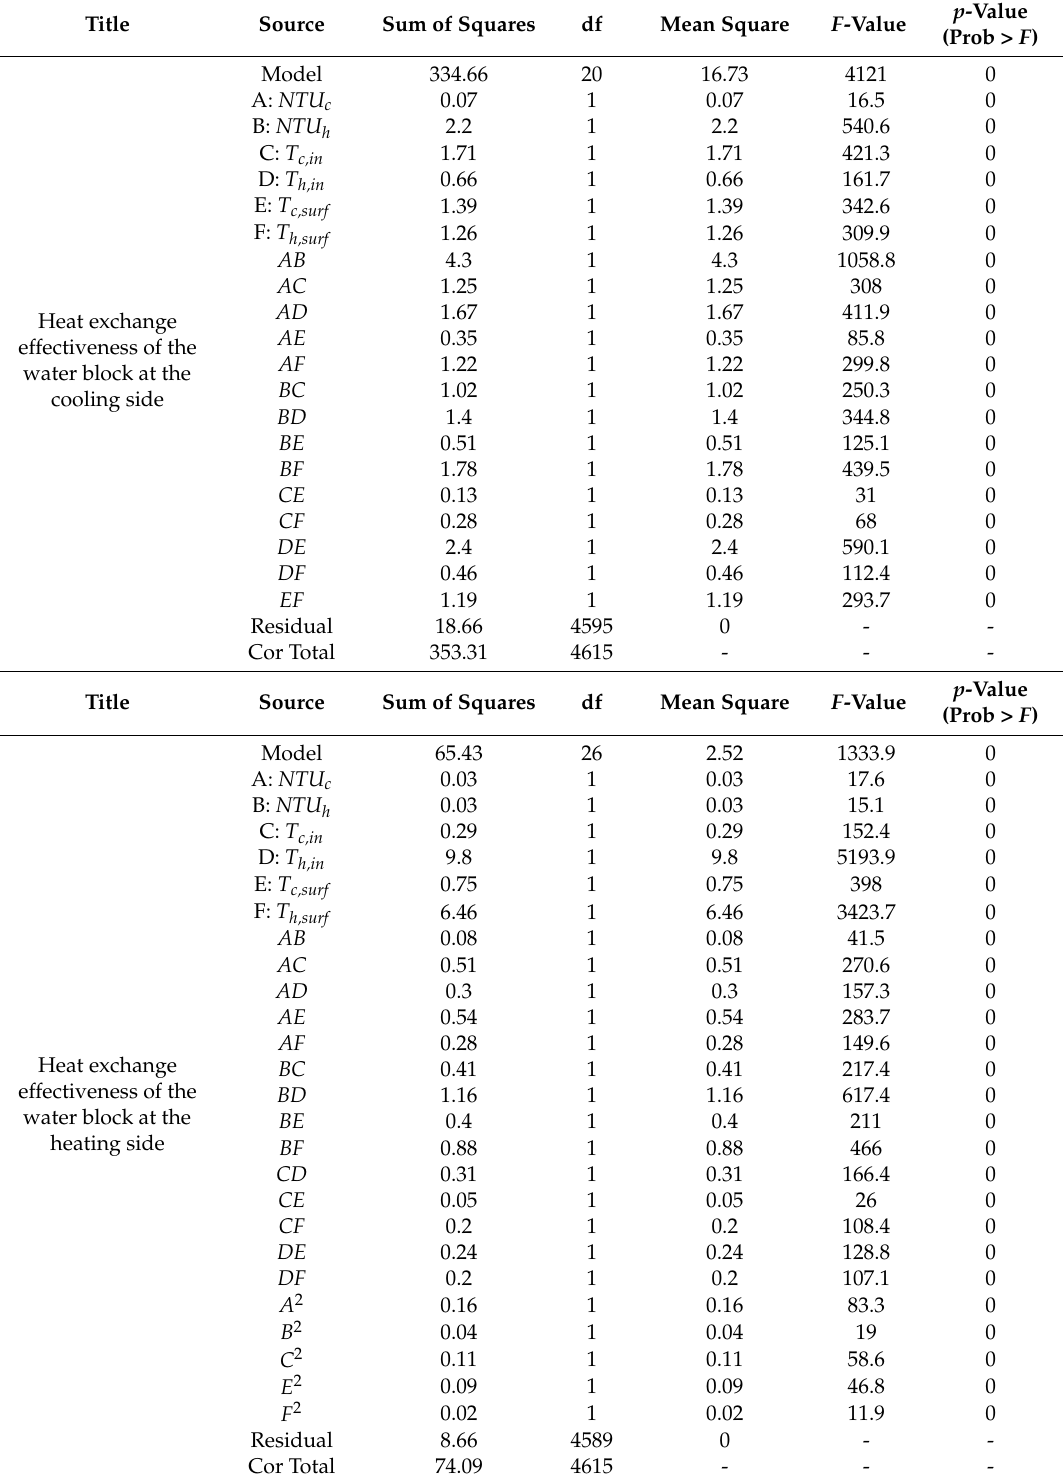
Table 4. ANOVA results of the heat exchange effectiveness of the water